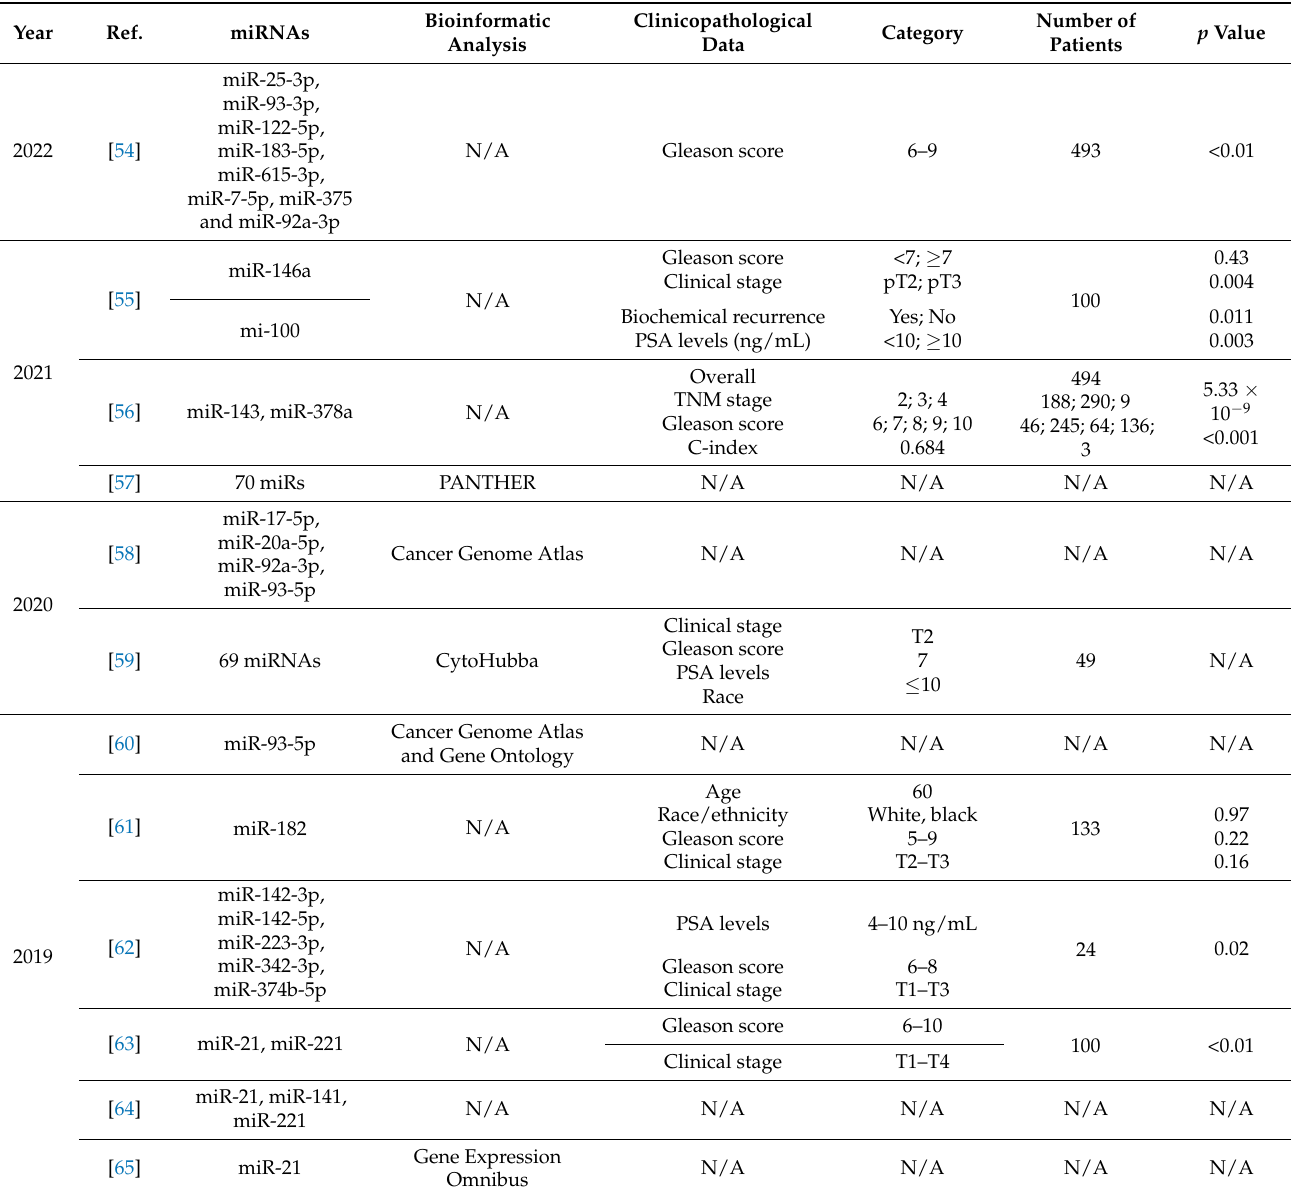
Table 2. List of the most relevant and representative papers clustered in topic 2 over time. N/A: Not